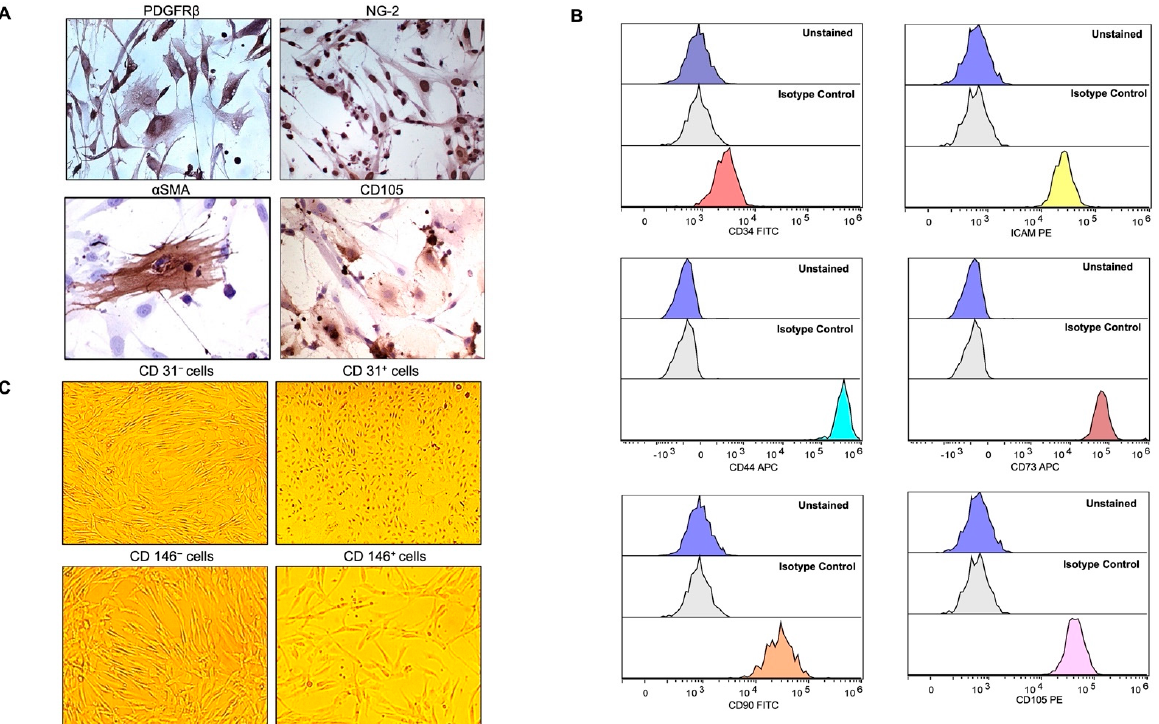
Figure 1. Expression of mesenchymal cell markers (MSCs) on cultured pericytes (PCs). ( A ) Immuno- histochemistry staining with CD31 − PCs were strongly positive for PDGFR β , NG-2, and most of the cells were positive for CD105 but slightly for α SMA. Pictures were taken at magnification 40 × after avidin-biotin peroxide staining. ( B ) Flow cytometry demonstrated CD31 − PCs to be mostly negative for CD34, and positive for ICAM1, CD44, CD73, CD90, and CD105. Histograms in the lowest panels (multicolor) represent the staining for specific antibodies as compared to the unstained and unrelated isotype-matched antibodies in blue and light grey histograms, respectively. ( C ) Bright-field microscopy depicting the morphology of CD31 − PCs versus CD31 + cells as the latter were distin- guished by the endothelial-cell-like cobblestone morphology from the elongated and slender shape of the former. CD31 − cells, selected for CD146-based MACS (CD146 − and CD146 + ), were similar in shape and morphology. Pictures were taken at a magnification of 10 ×